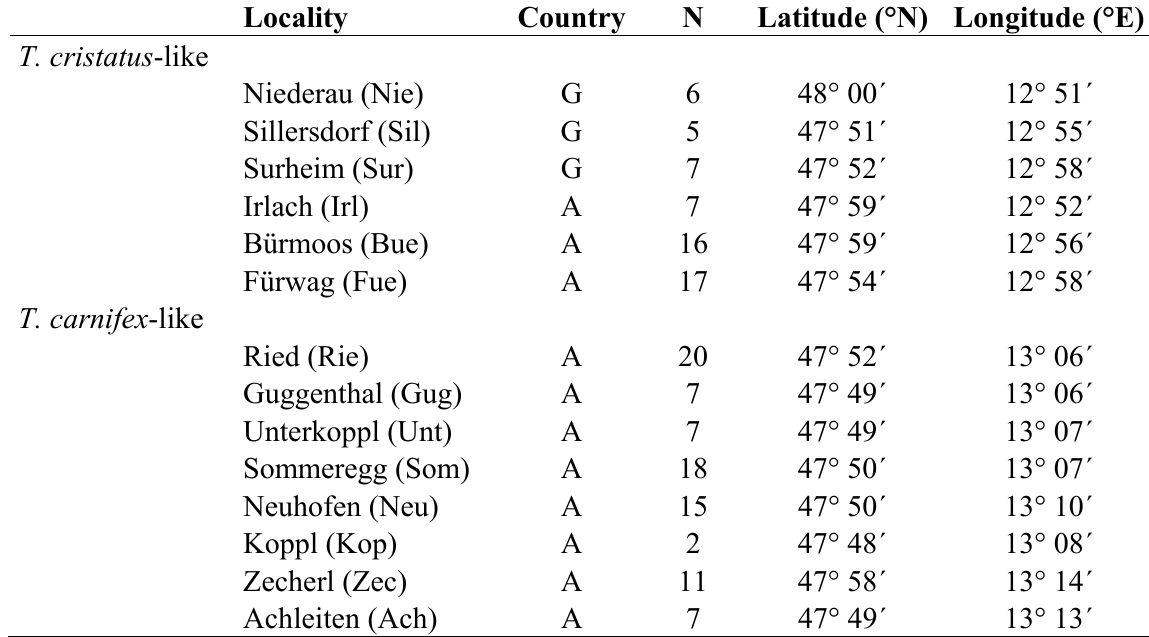
Table 1. Sampling localities with abbreviations in parentheses, country of origin (G = Germany, A = Austria), number of sampled individuals (N) and geographical coordinates.